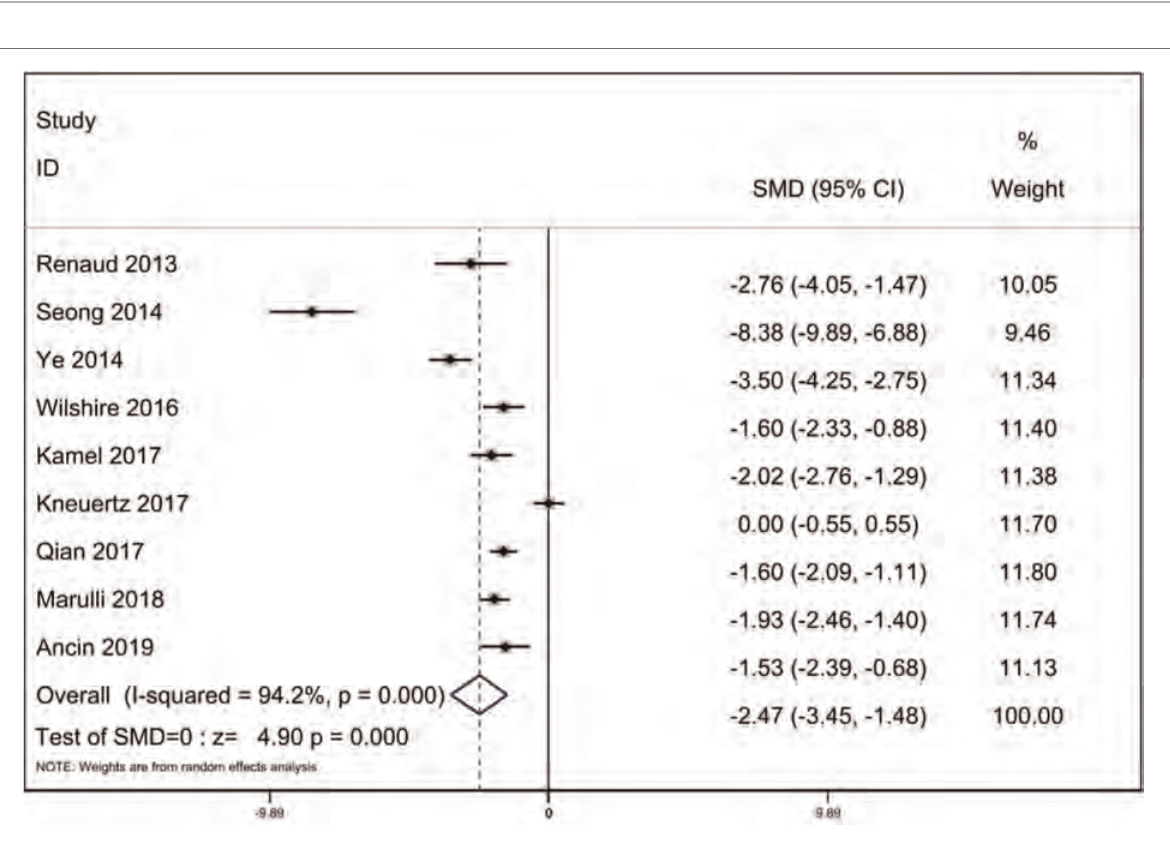
FIGURE 5 Comparison of postoperative drainage time between RATS and ST. SMD, standardized mean difference; CI, con fi dence interval; RATS, robot-assisted thoracoscopic surgery; ST,